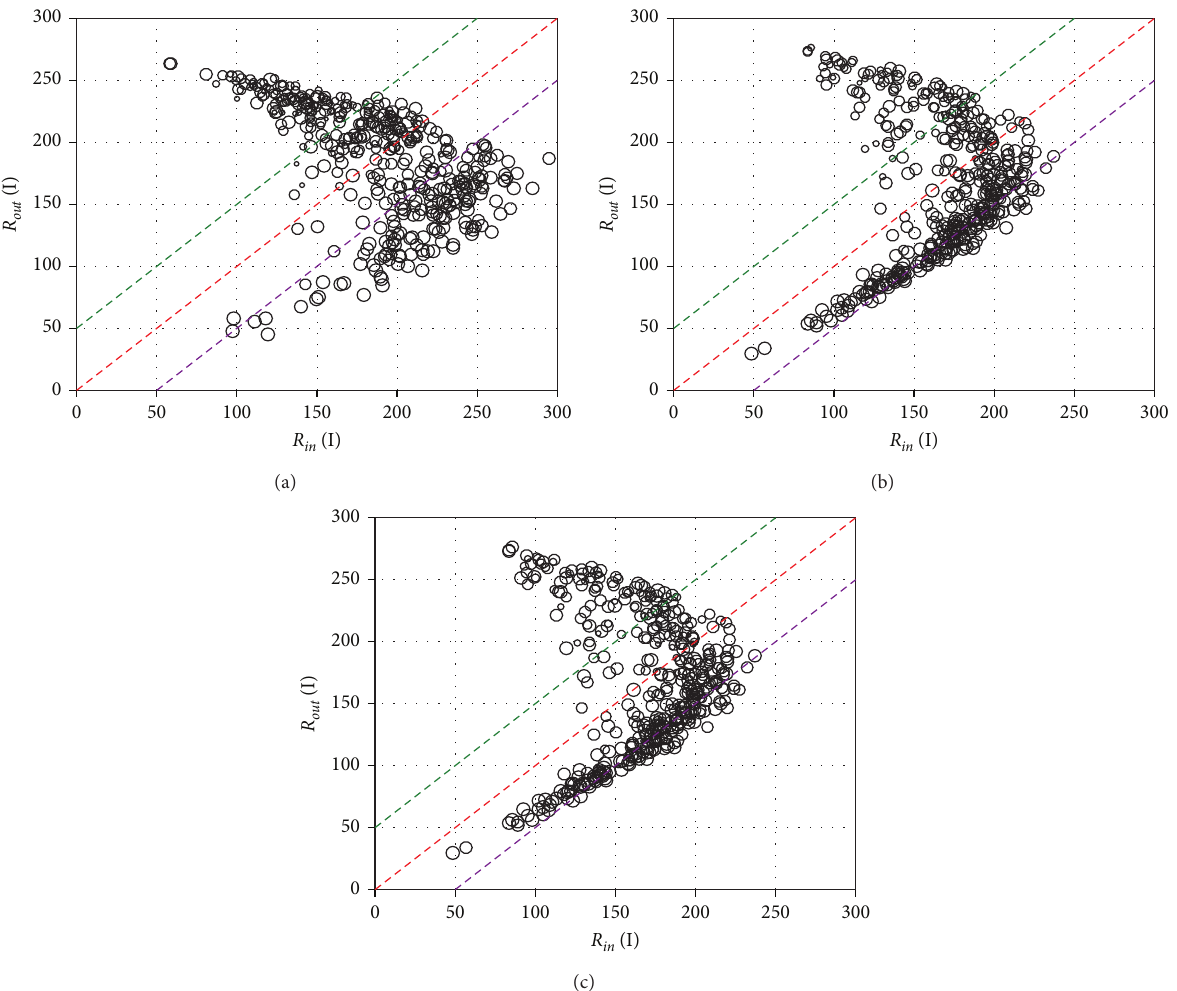
Figure 10: Distribution of influence coefficients and affected coefficients for road network: (a) morning peak time; (b) nonpeak time; (c) evening peak time.